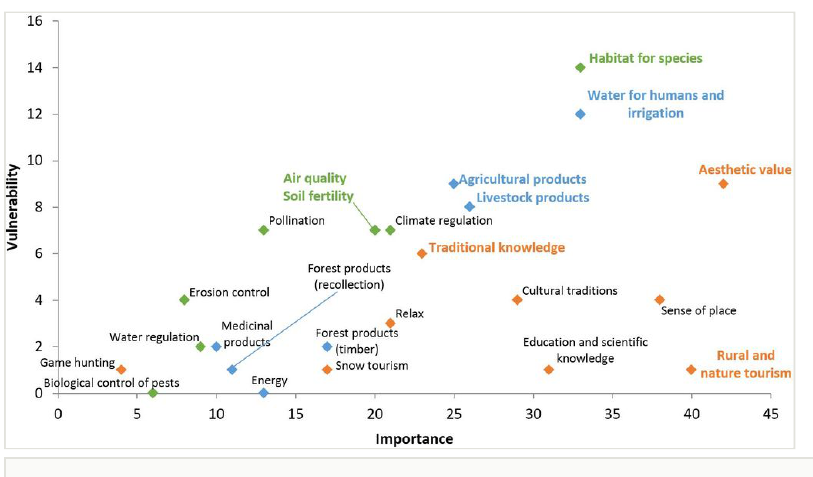
Scatter plot of the importance (X axis) and vulnerability (Y axis) of ES as perceived by key stakeholders during the interviews. Blue, green and orange dots represent provisioning, regulating and cultural services respectively. The names in bold are the selected ES for the